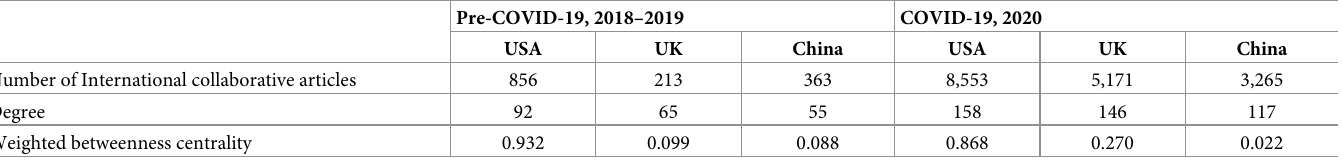
Table 8. Network metrics for USA, UK, and China, pre-COVID and